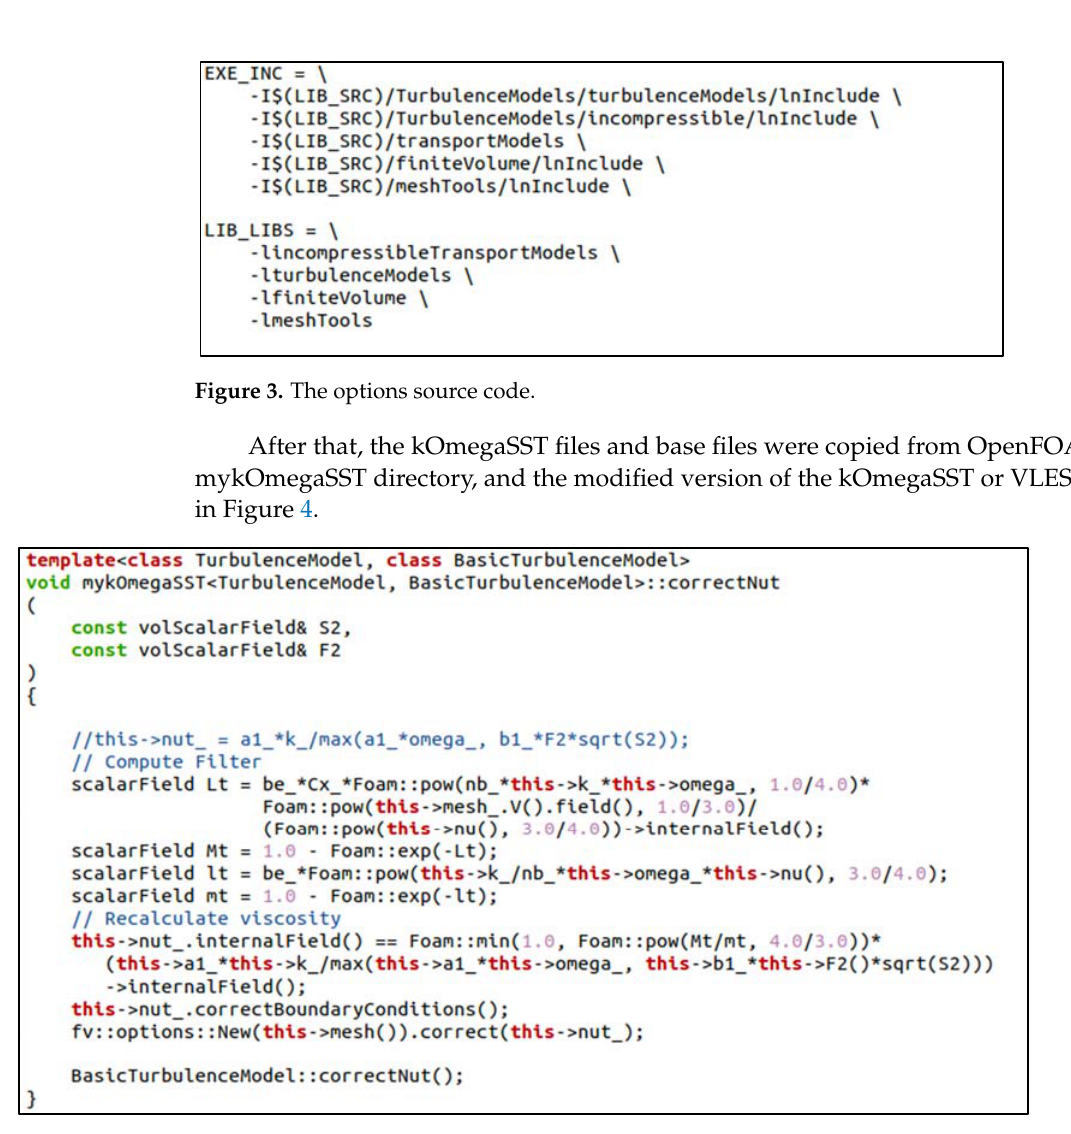
Figure 4. The modified turbulence viscosity for VLES.